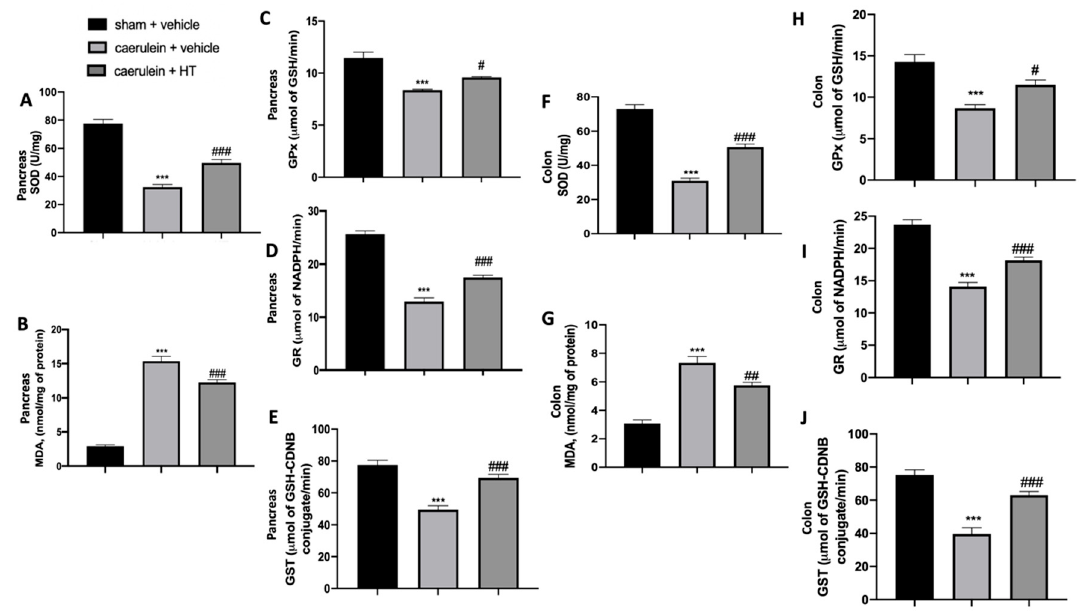
Figure 2. Hydroxytyrosol (HT) effect on oxidative stress induced by caerulein administration: pancreas tissue: superoxide dismutase (SOD) ( A ), malondialdehyde (MDA) ( B ), glutathione peroxidase (GPx) ( C ), glutathione reductase (GR) ( D ), glutathione S-transferase (GST) ( E ), colon tissue: SOD ( F ), MDA ( G ), GPx ( H ), GR ( I ), GST ( J ). For each analysis, n = 5 animals from each group were employed. A p - value < 0.05 was considered significant. # p < 0.05 vs. caerulein + vehicle, *** p < 0.001 vs. sham + vehicle, ### p < 0.001 vs. caerulein + vehicle.